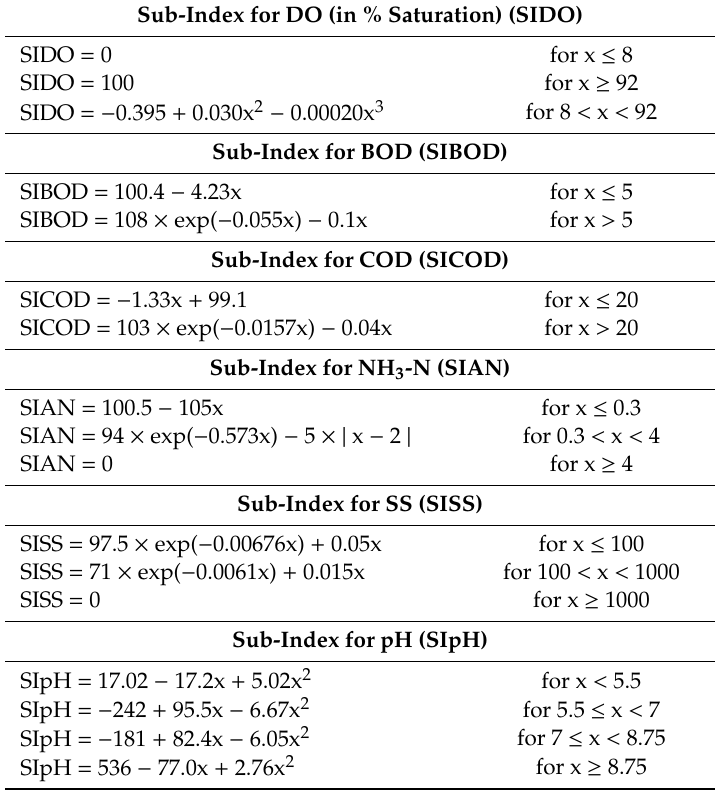
Table 4. Best fit equation for the estimation of various sub-indices values.